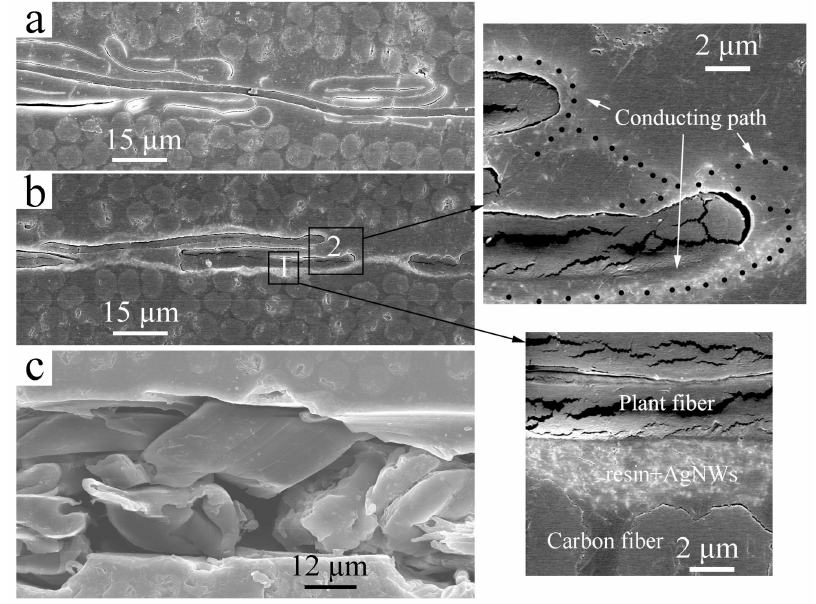
Figure 6. SEM images of the cross section of the interleaved composites. ( a ) Interleaved with plain paper; ( b ) Interleaved with conductive paper. Region 1: An enlarged image of the area between carbon fibers and plant fiber. Region 2: The conducting path formed by AgNWs; ( c ) Polished plain paper interleaved sample with an open crack.